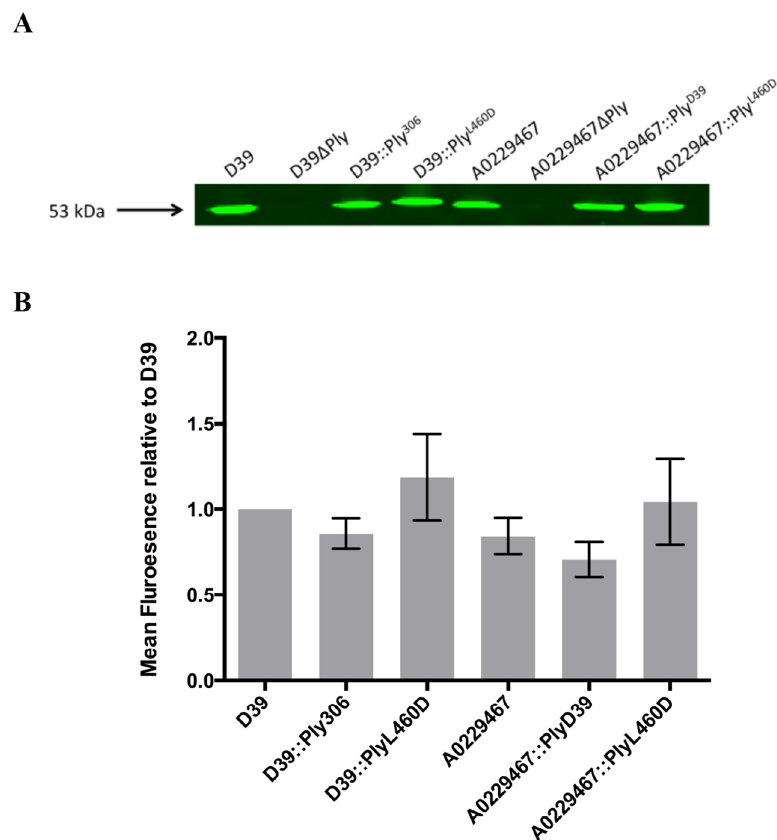
Figure 2. Ply expression. Ply expression analysis. Ply expression was compared between D39, D39 D Ply, D39::Ply306, D39::PlyL460D, A0229467, A0229467 D Ply, A0229467::PlyD39 and A0229467::PlyL460D by quantitative western blot using Ply-specific mouse antisera (A) The size of Ply (53 kDa) is indicated. The mean fluorescence units relative to D39 from biological triplicates are shown (B). Error bars indicate the SEM. Relative expression was compared between strains using the one-way ANOVA and Kruskal-Wallis and Dunn’s multiple comparisons test, where P , 0.05 would indicate statistical significance.